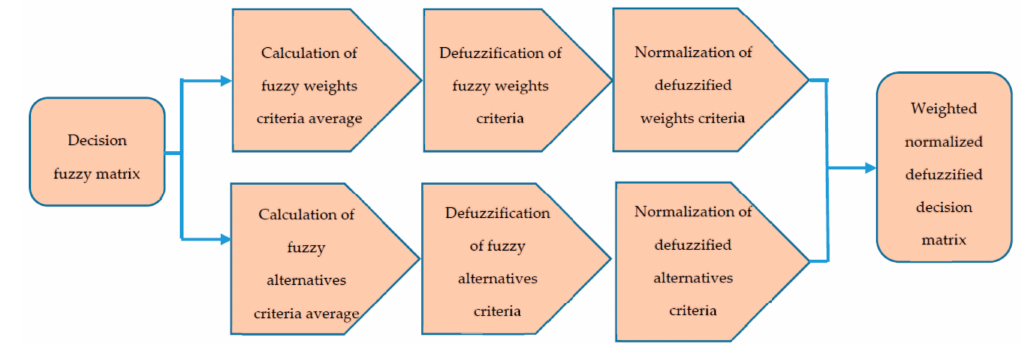
Figure 8. Weighted normalized defuzzified